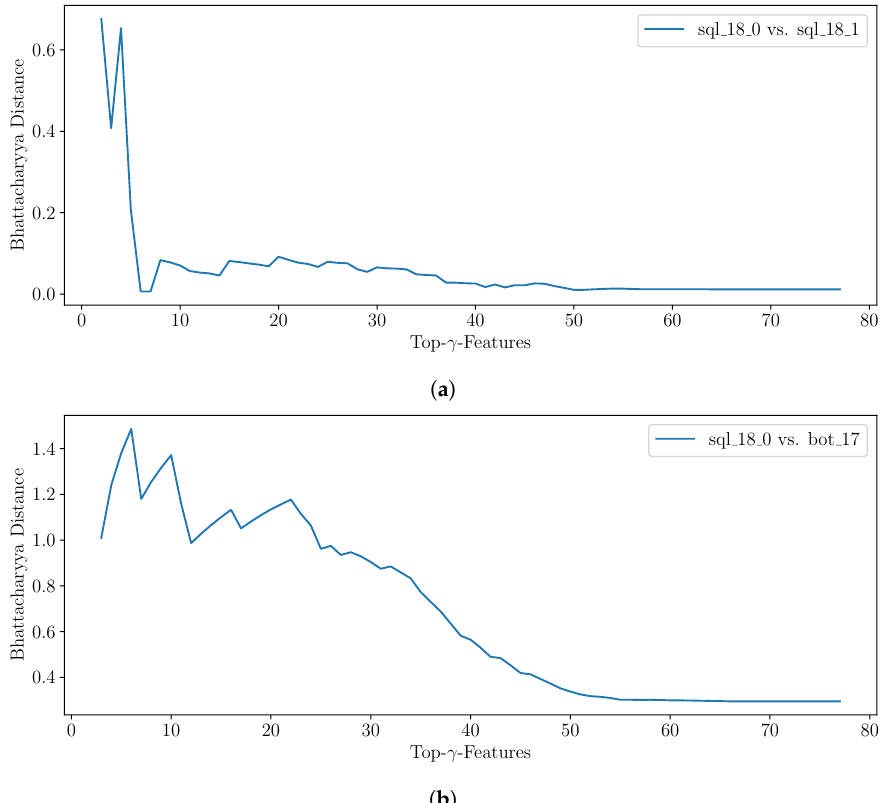
Figure 10. The dependency of γ on the Bhattacharyya distance (similarity) of two highly similar ( a ) and dissimilar ( b ) attack scenarios.